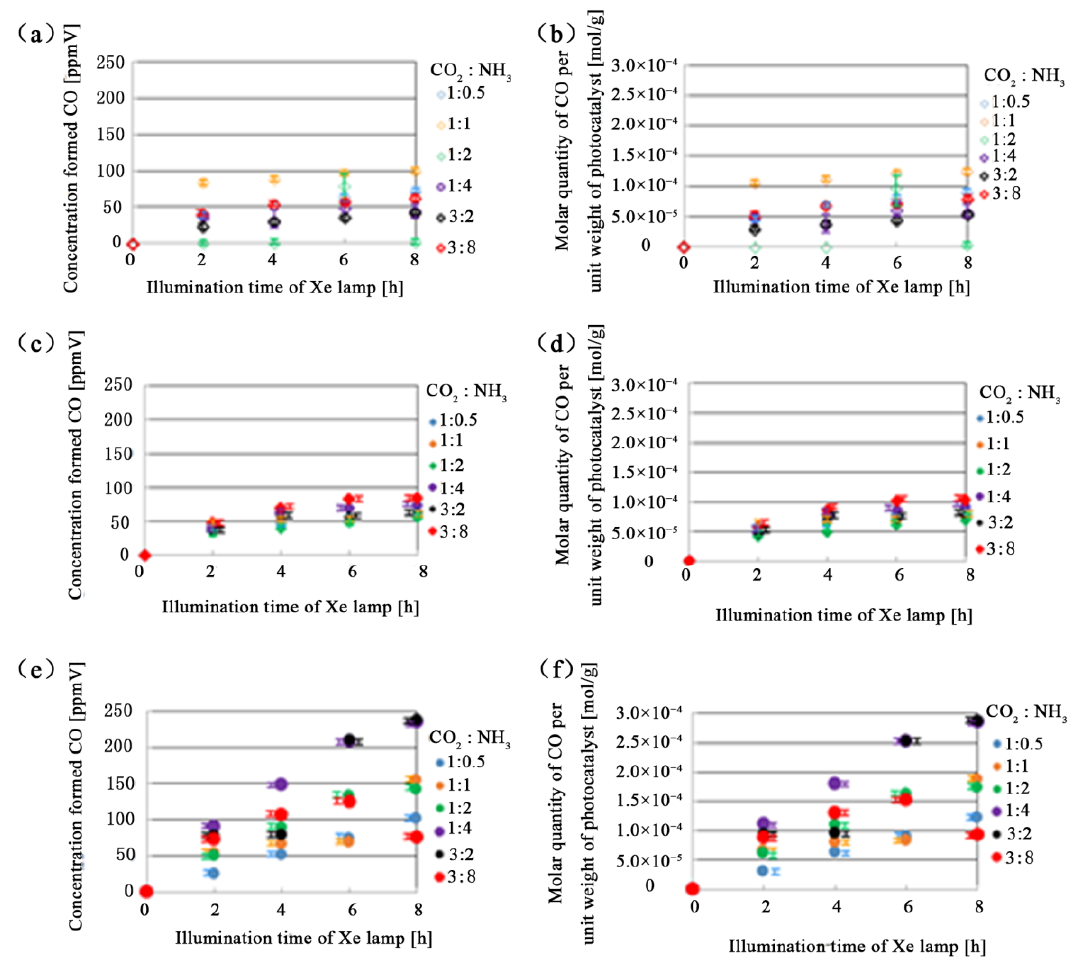
Figure 2. Comparison of concentration of formed CO among different molar ratios (( a , b ): W/O B.B., ( c , d ): W B.B.-1, ( e , f ): W B.B.-3).